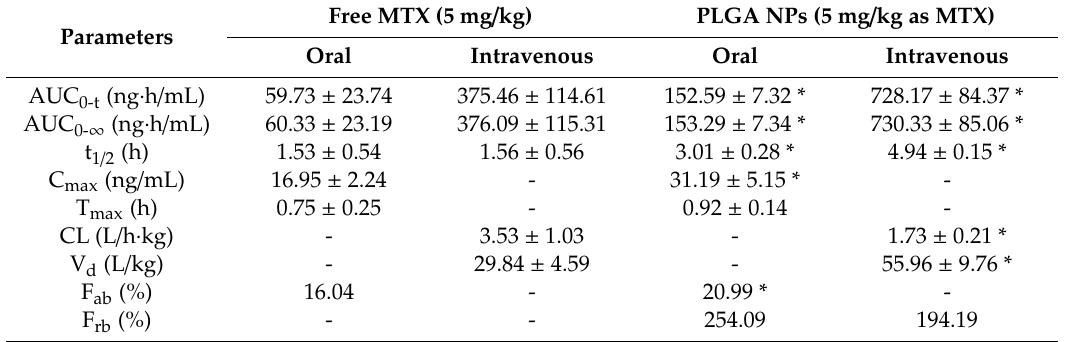
Figure 11. Mean plasma concentration-time profiles of MTX after oral ( a ) or intravenous ( b ) administration of free MTX (- ● -, 5 mg/kg) and MTX-loaded PLGA NPs (- ○ -, 5 mg/kg as MTX) to rats. Vertical bars represent standard deviation of the mean ( n = 5). Table 6. Pharmacokinetic parameters of MTX after administration of MTX-loaded NPs or free MTX in rats ( n = 5, mean ± SD).